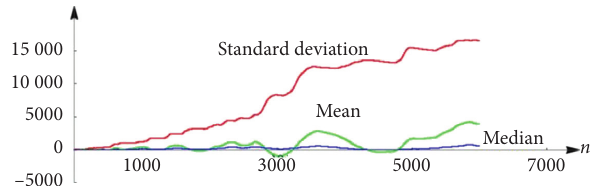
Figure 7: The scatter plot of M colored) for n from 1 to 2,000.